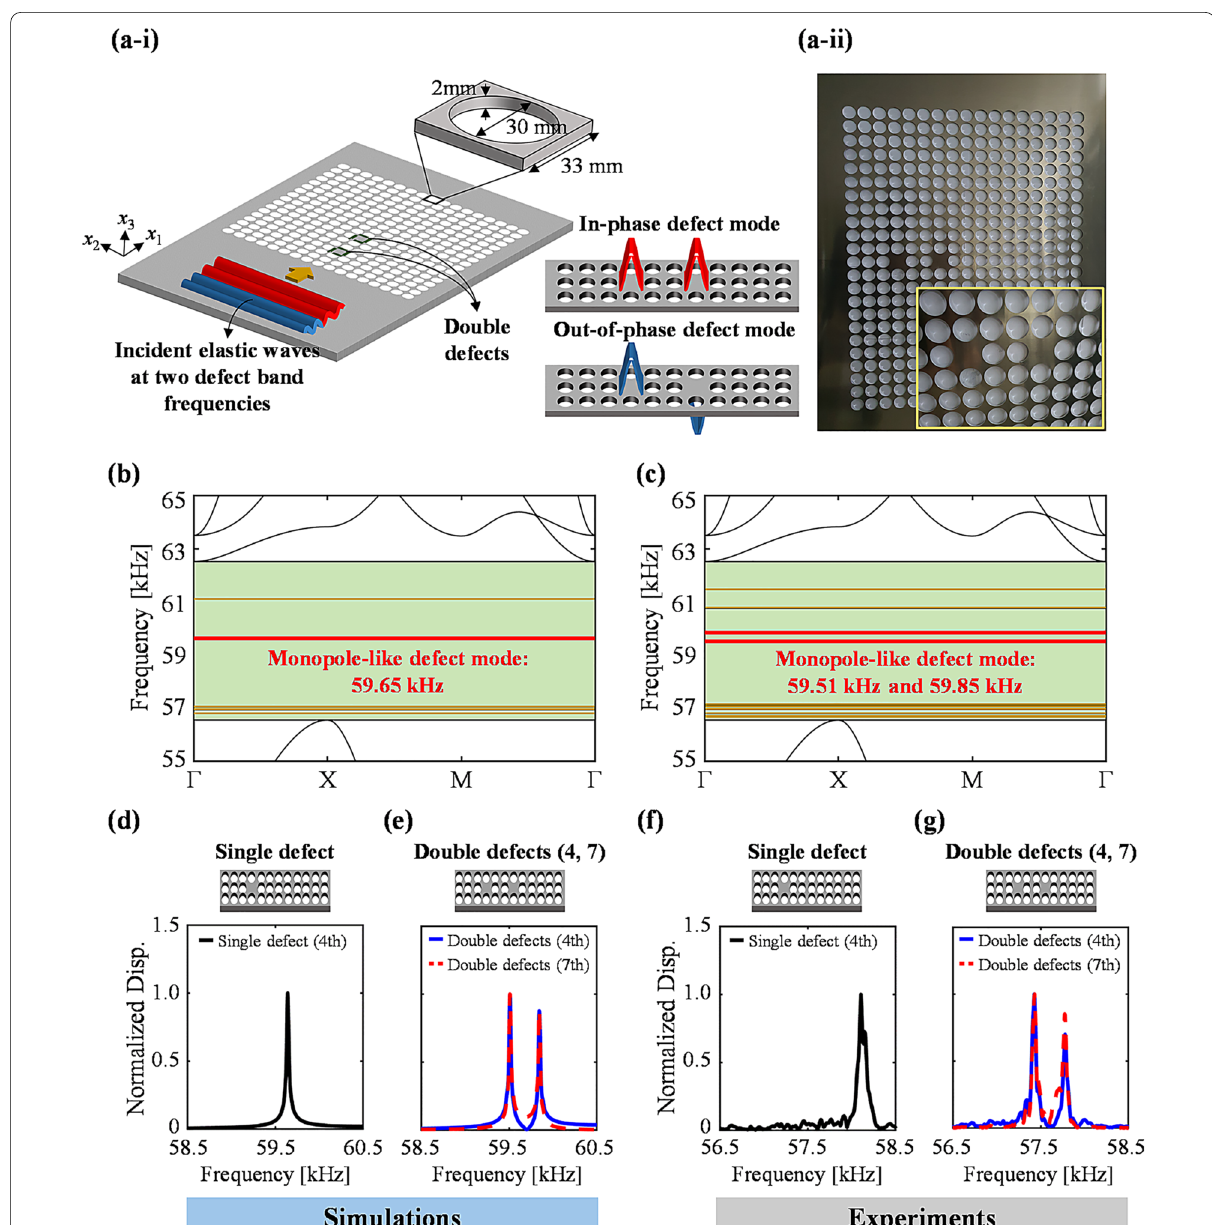
Fig. 1 Numerical simulation and experiment results of elastic wave localization that leverages the defect band splitting phenomenon of a phononic crystal with double defects (4, 7). a A schematic illustration (left) of in‑phase and out‑of‑phase localized behaviors at each frequency of split defect bands and a snapshot (right) of one fabricated specimen. b Formation of five defect bands in the band gap, ranging from 56.55 kHz to 62.51 kHz, and the highlighted target defect band of 59.65 kHz presenting the monopole‑like defect mode shape. c Splitting of the five defect bands presented in b into ten defect bands due to coupling between the double defects (4, 7), and the highlighted target defect bands of 59.51 kHz and 59.85 kHz. ( d , e ) Numerically and ( f , g ) experimentally demonstrated the defect band splitting phenomenon via comparison of the normalized out‑of‑plane displacement frequency responses functions in the cases of single and double defects (4, 7),